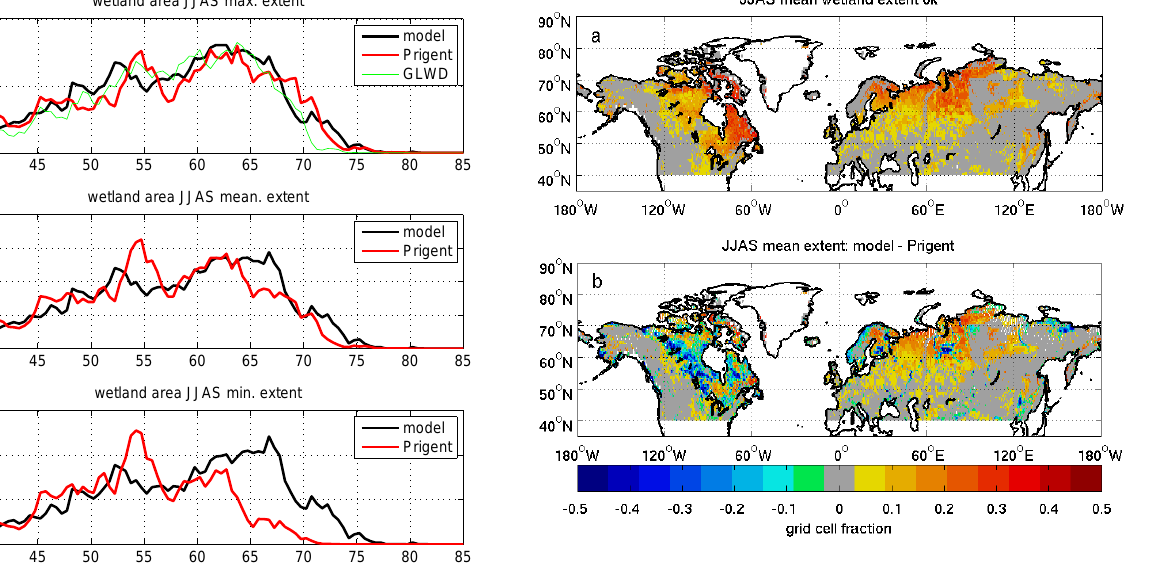
Fig. 3. Summer (JJAS) mean wetland extent at 0ka. Upper panel (a) : Wetland extent as grid cell fraction. Lower panel (b) : Differ- ence to remote sensing data by Prigent et al. 2007